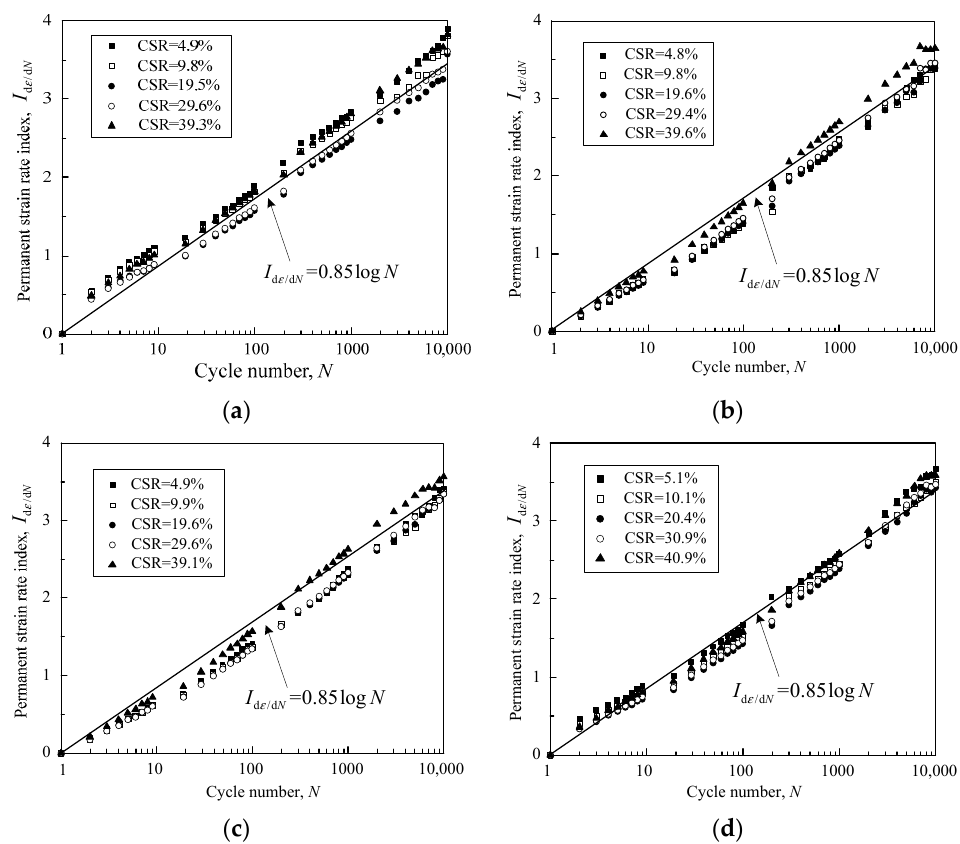
Figure 11. The relationship between strain rate index and loading cycles for the granular samples with ( a ) DoC =0.95, σ 3 = 40 kPa; ( b ) DoC = 0.95, σ 3 = 60 kPa; ( c ) DoC = 1.00, σ 3 = 40 kPa; and ( d ) DoC = 1.00, σ 3 = 60 kPa.